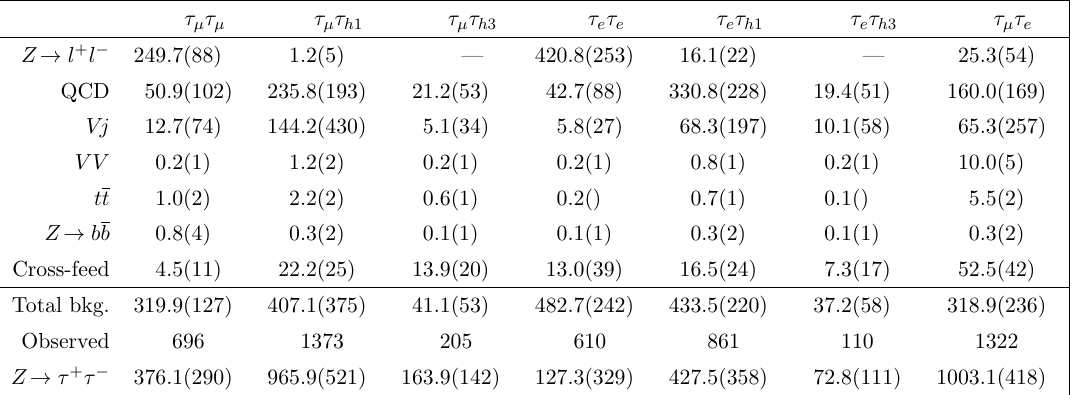
Table 1 . Expected backgrounds yields and total number of candidates observed. In the last row the uncertainties are the statistical and systematic contributions